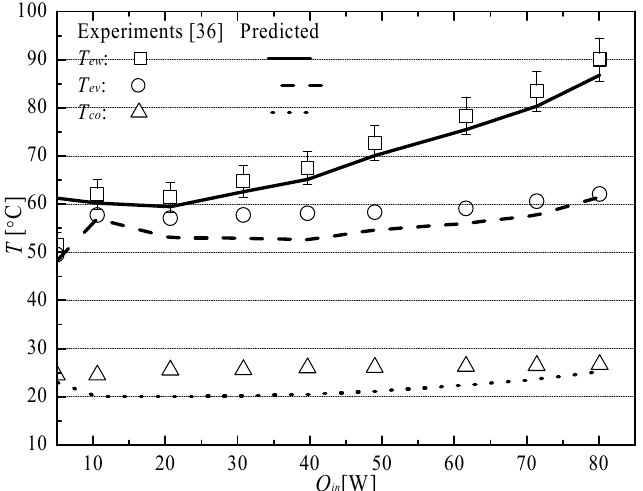
Figure 6. Comparison between model prediction and the experimental data of an FLHP with methanol as a working fluid (Boo and Chung [36]). Table 2. FLHP geometric characteristics and working conditions.